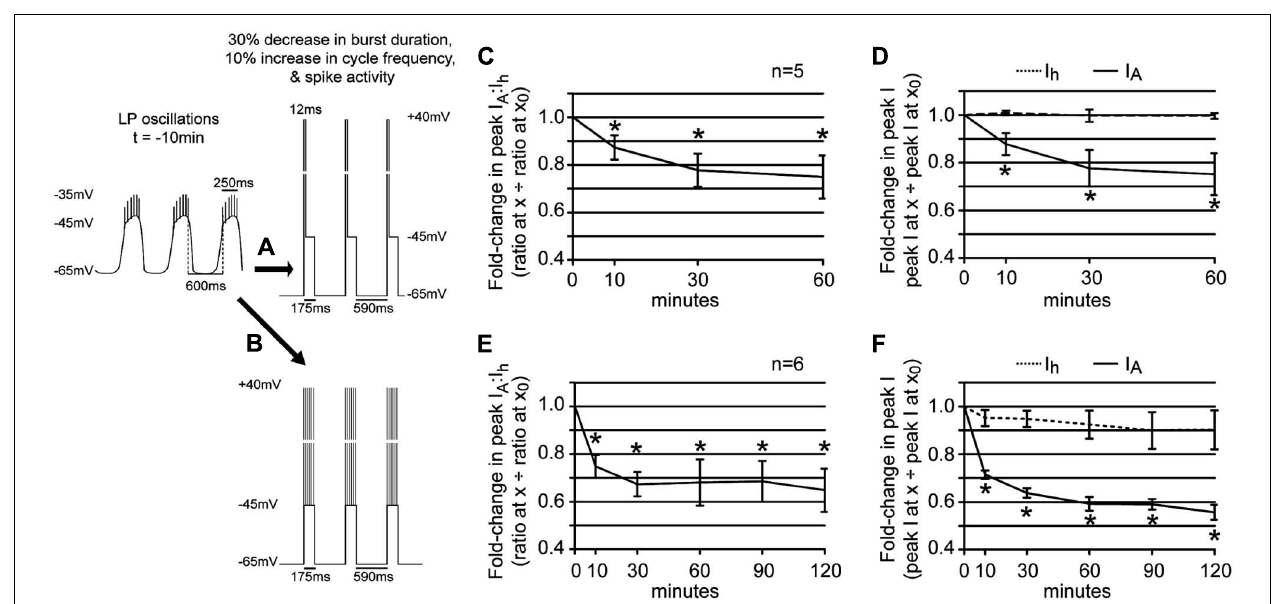
fold-changes in peak LP I A and I h (mean ± SEM) from the same experiments as in (C) ; * p < 0.05 for I A only, repeated measures ANOVAs with Dunnett’s post hoc tests (see text). (E) Plot of the fold-changes in the LP I A : I h ratio (mean ± SEM) throughout a 2 h superfusion with 5 μ M DA and implementation of a recurring voltage step indicated by protocol B.The ratio significantly decreased with time; * p < 0.05, repeated measures ANOVA with Dunnett’s post hoc tests that compare all time points to t = 0, F (5,4) = 8.728, p = 0.0002. (F) Plots of the